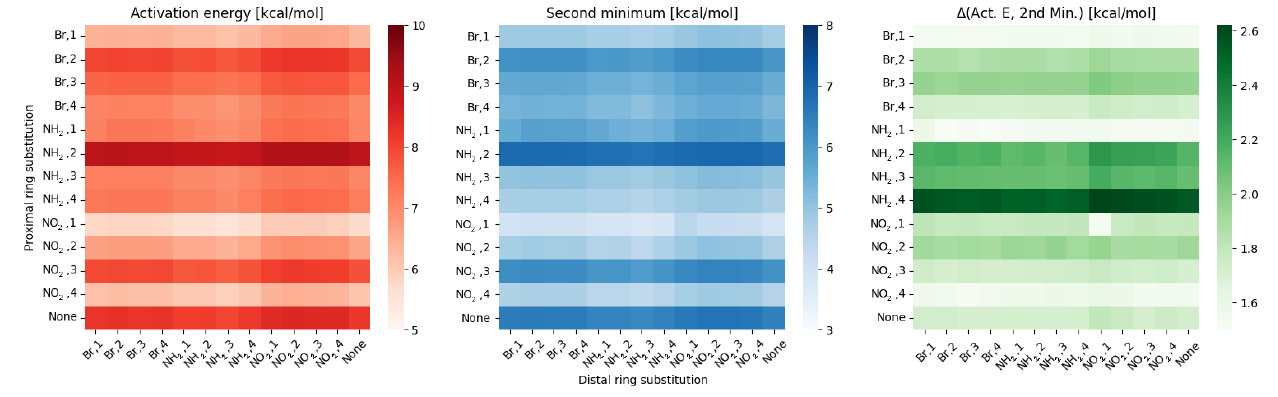
Figure 3. Heatmaps of the activation energy ( left ), second minimum ( middle ) and the difference between them ( right ) for different substitution patterns in the para compounds group.